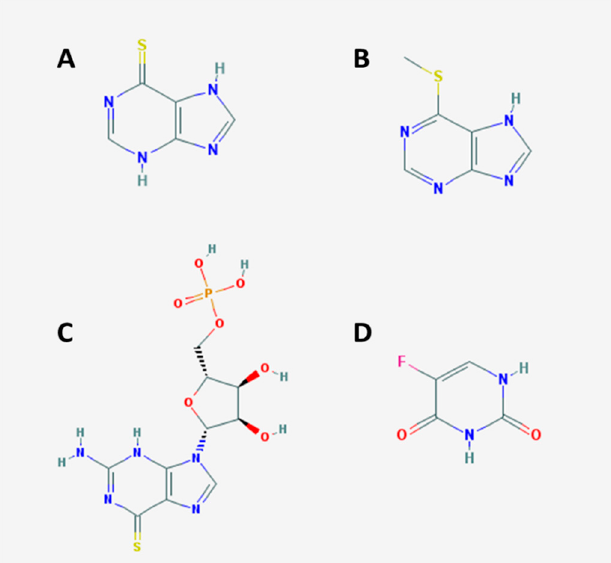
Figure 1. Chemical structures of ( A ) 6-mercaptopurine (6-MP); ( B ) 6-methylmercaptopurine (6-MMP); ( C ) 6-thioguanosine-5 ′ -monophosphate (6-TGMP); and ( D ) 5-fluorouracil (5-FU).